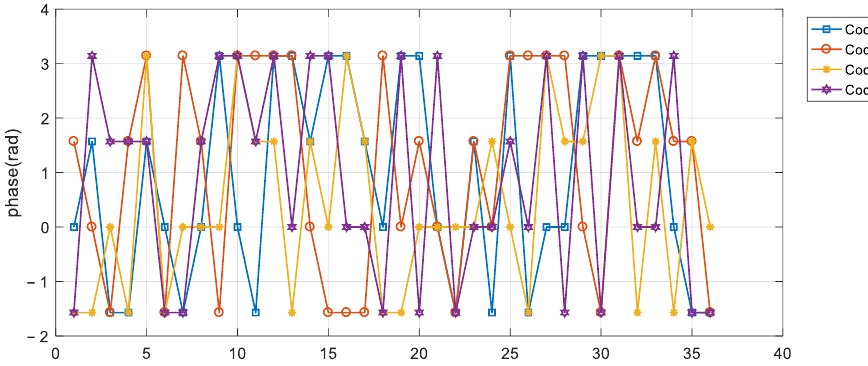
Figure 6. SA Optimized codes ( L = 4, M = 4, N = 36).